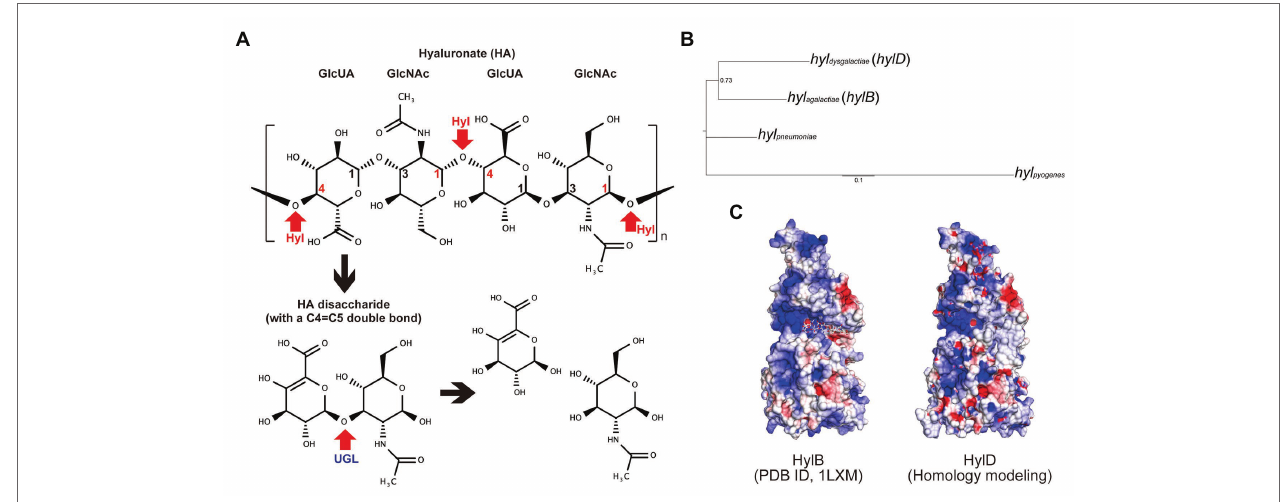
FIGURE 1 | Streptococcal hyaluronate lyases. (A) Schematic diagram of hyaluronate (HA) degradation of Hyl and UGL. β 1,4 linkages between glucuronic acid (GlcUA) and N-acetylglucosamine (GlcNAc) were degraded by hyaluronate lyase (Hyl; represented in red arrows). The resultant unsaturated HA disaccharides were hydrolyzed by unsaturated glucuronyl hydrolase (UGL; represented by a red arrow). The chemical formula was drawn by MarvinSketch software (ChemAxon). (B) Genetic diversity of streptococcal hyaluronate lyases (Hyls) from S. pyogenes strain 476 (locus tag: M1GAS476_0819), Streptococcus pneumoniae strain R6CIB17 (E5Q10_01570), Streptococcus agalactiae strain COH1 (GBSCOH1_1103), and Streptococcus dysgalactiae subsp. equisimilis (SDSE) strain 124 (SDEG_0654). (C) Structural similarity of HylB (PDB ID, 1LXM) and HylD (homology modeling using 1LXM) from S. agalactiae and SDSE,